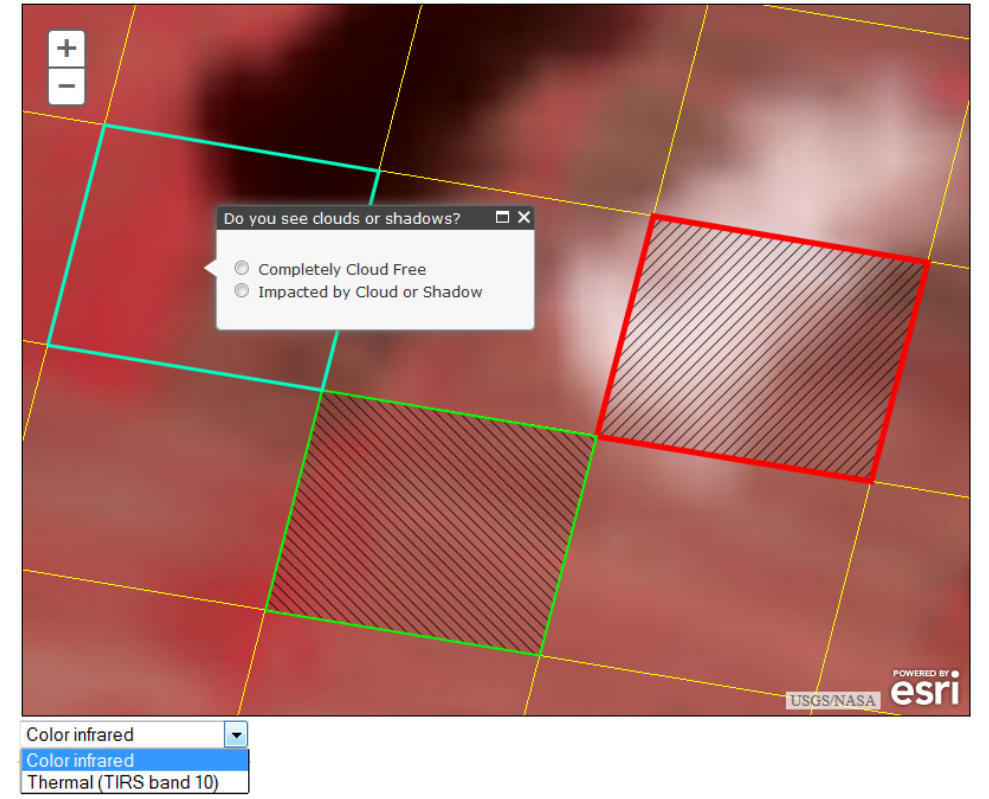
Figure 2. Example of selected cell for CSC impact decision. The selected cell is highlighted with a blue frame. Previously interpreted cells are shaded and have a red (impacted) or a green (CCS-free)